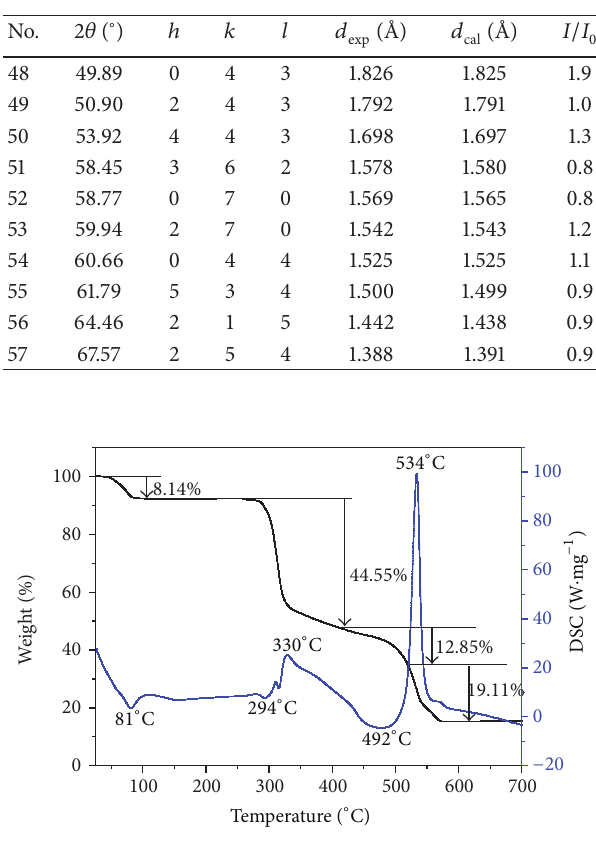
Figure 6: TG-DSC curves of the title